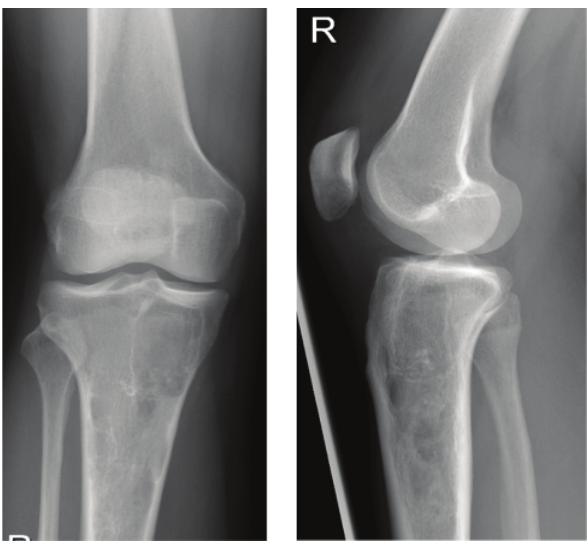
Figure 1: Pre-operative antero-posterior and lateral plain radiograph demonstrating large enchondroma of the proximal tibia.